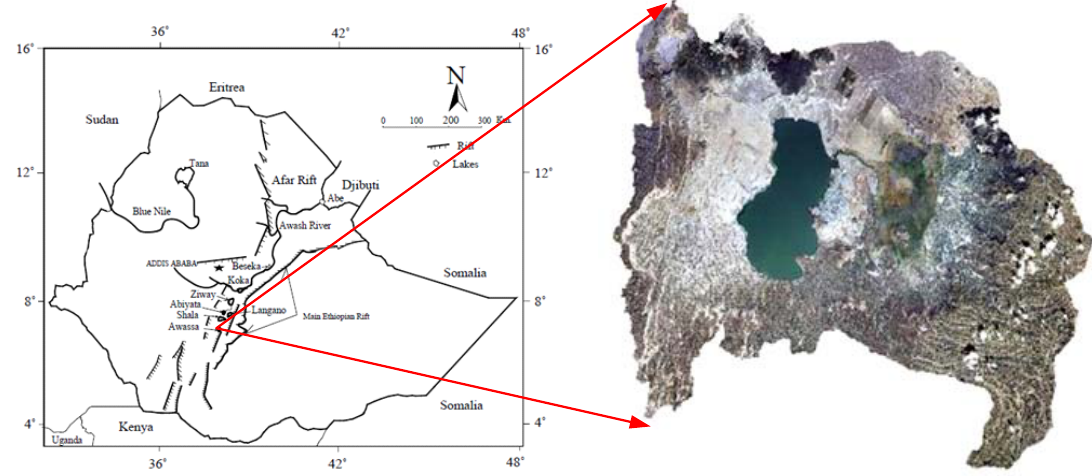
Figure 1. Location map of the study area (Source: Belete et al. [21])